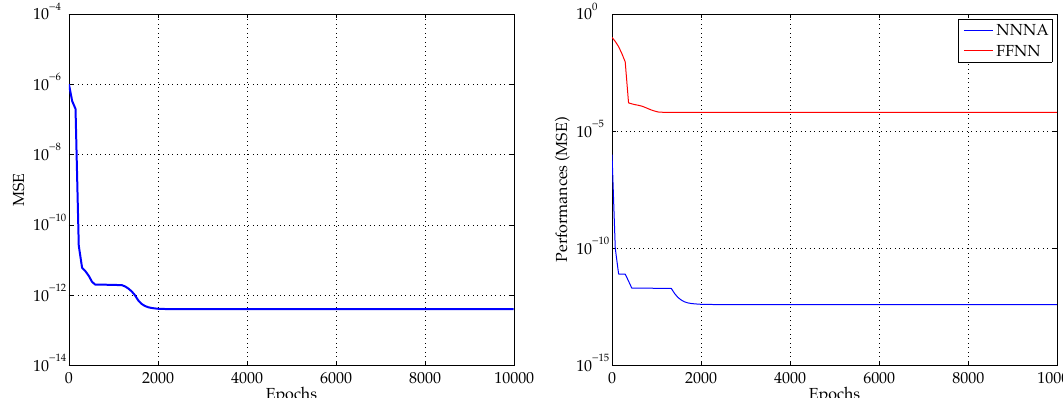
Figure 5. Global performance plot of the implemented Nested Neural Network Architecture (NNNA) ( left panel ), and a comparison with the performances obtained by using two separate Feed Forward Neural Networks (FFNNs) ( right panel ).